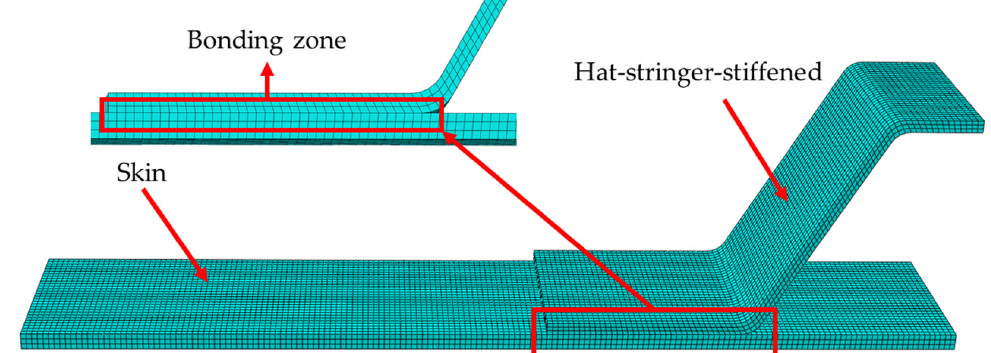
Figure 7. 3D finite element model of the four-point bending test. Table 3. Interfacial parameters of cohesive elements.